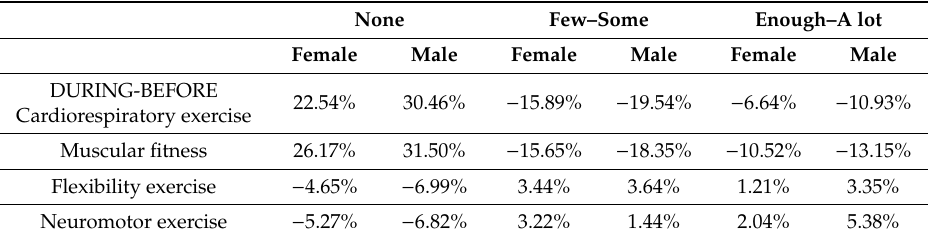
Table 6. Di ff erences (during-before) by gender in each type of PA practice.